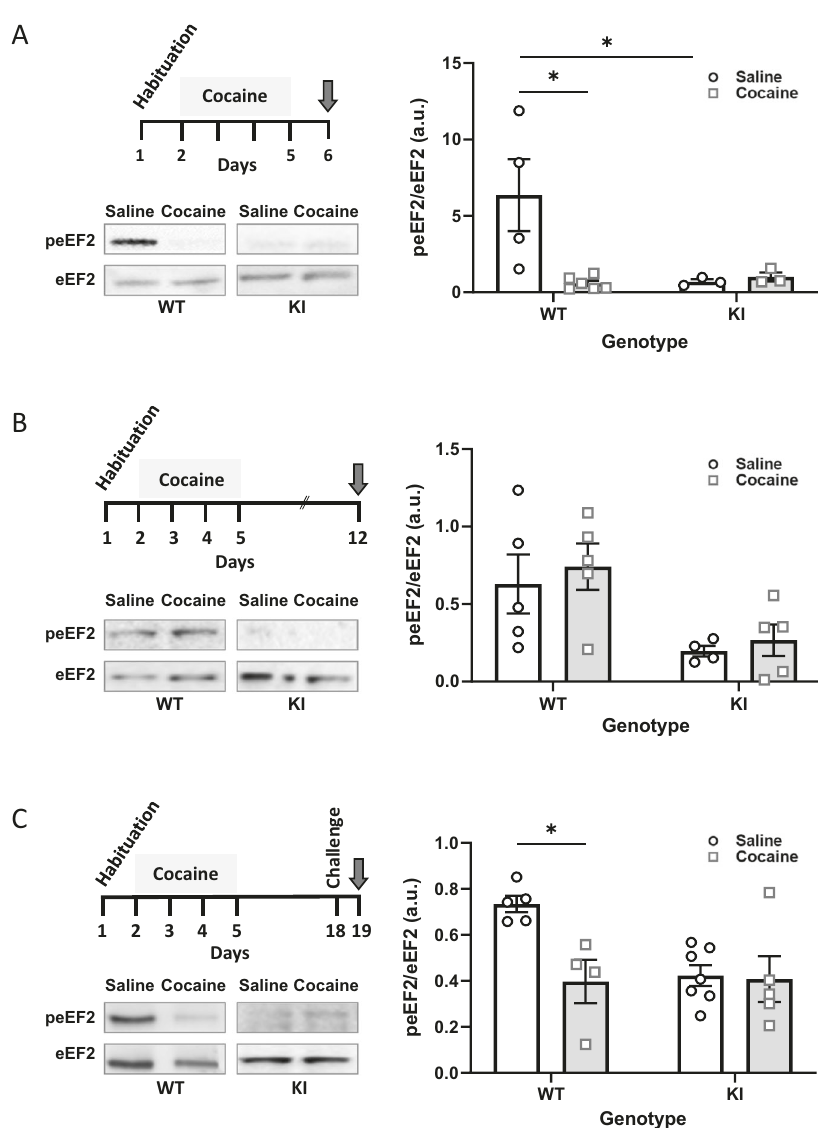
Fig. 3 Cocaine reduces phosphorylation of eEF2 in the NAc at 1 day after psychomotor sensitization or following challenge in WT but not KI mice. peEF2/eEF2 ratio analysed by western blot using peEF2 and eEF2 antibodies. NAc brain homogenates were taken from mice euthanized ( N = 3 – 7), A one day (day 6) following psychomotor sensitization, B seven days following psychomotor sensitization. C Mice underwent psychomotor sensitization from days 2 – 5, followed by 14 days of withdrawal and euthanized on day 19, one day following cocaine challenge (15 mg/kg; day 18). Data shown ± SEM. Data were analysed by two-Way ANOVA followed by Tukey ’ s post-hoc where appropriate. * p <